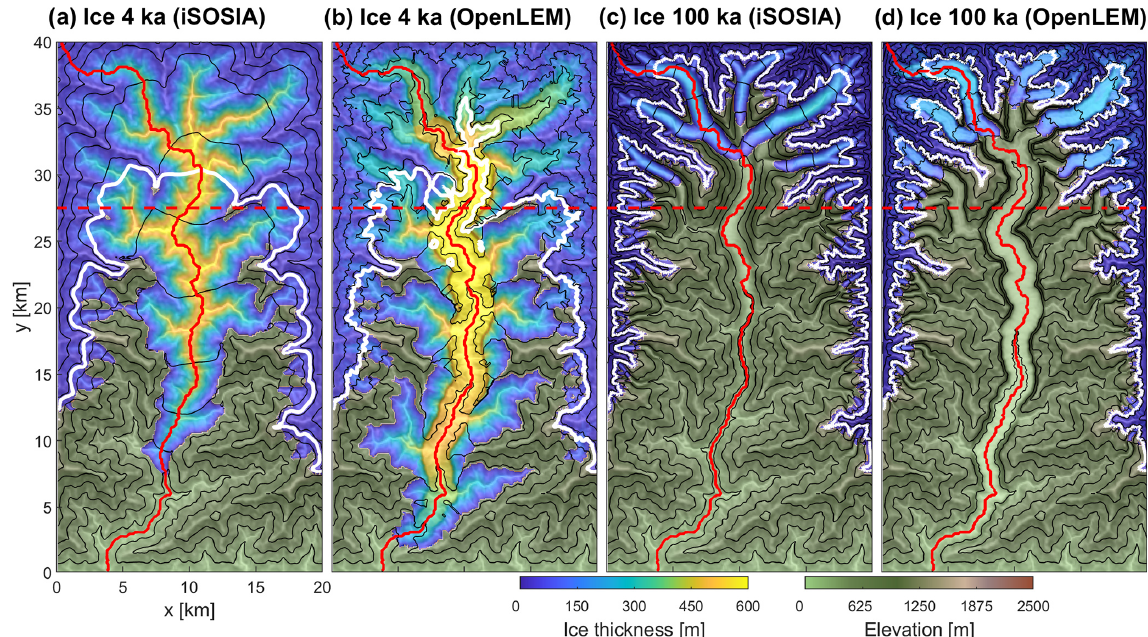
Figure 6. Differences in ice configuration in the numerical experiments with a elevation-dependent ice production rate (ELA = 1330m). (a, b) Ice thickness after 4ka and (c, d) after 100ka for iSOSIA and OpenLEM ( δ = 0 . 25, a = 150m 0 . 4 ). The spacing of the contour lines is 200m. The 1330m contour line is highlighted in white. The path of the cross-sectional and glacier-long profiles depicted in Figs. 5 and 9 are shown as a dashed and continuous red line, respectively.